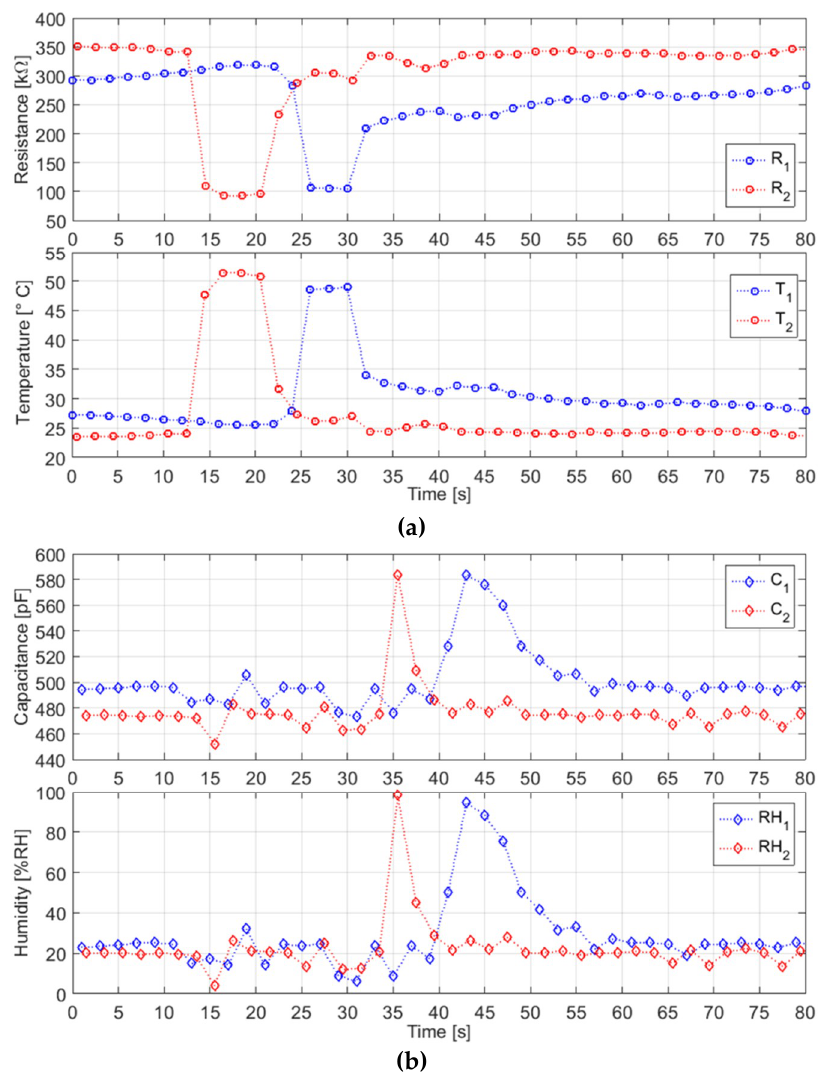
Figure 10. Continuous measurement of temperature and relative humidity (RH) with the system prototype: ( a ) measured resistance and temperature trends versus time; ( b ) measured capacitance and relative humidity trends versus time.